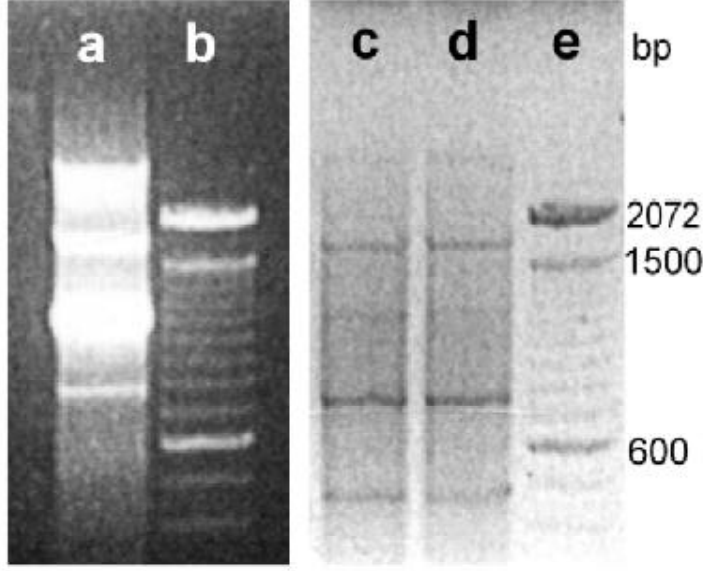
FIGURE 2. PCR results obtained by using ERIC sequences as primers for the amplification of the genomic DNA from GCH1 strain isolated from: (Lane a) pure bacterial culture in LB liquid medium; (Lanes c, d) soil samples inoculated with GCH1 at different doses; (Lanes b, e) 100 bp DNA ladder marker (GibcoBRL) (2